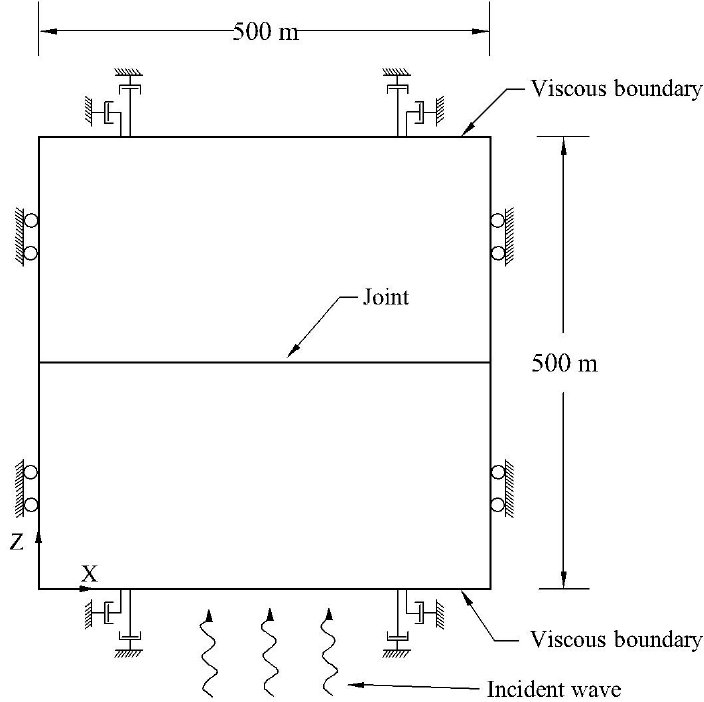
Figure 1. Fast Lagrangian Analysis of Continua (FLAC) model for P wave transmission through a single joint.